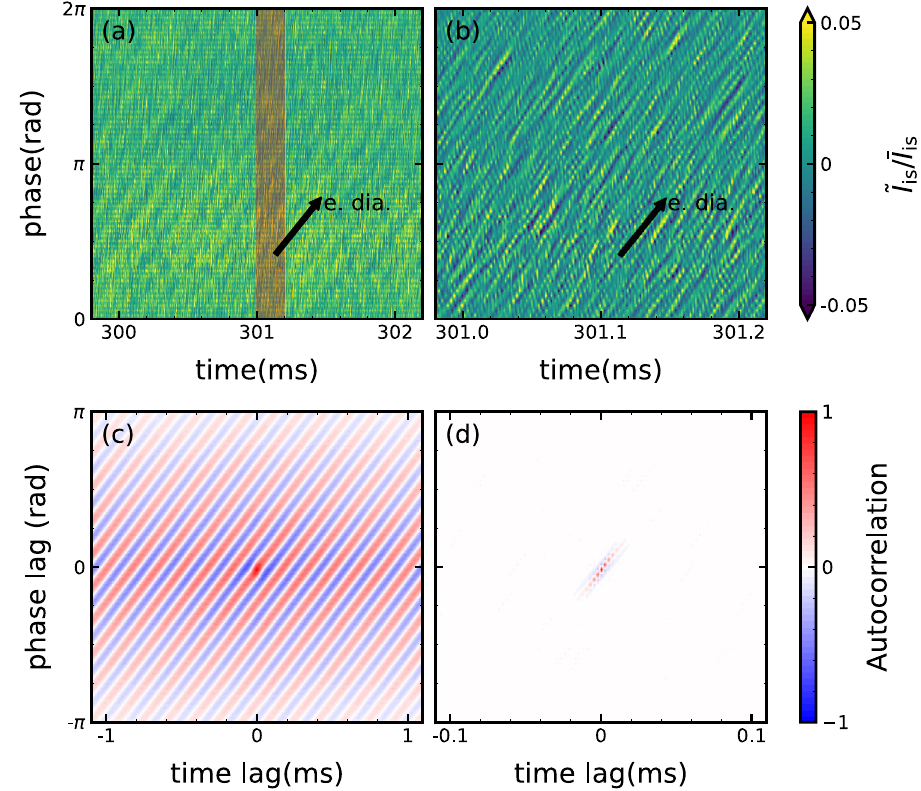
Figure 2. ( a ) Spatiotemporal evolution of normalized ion saturation current. ( b ) An enlarged view of the red shaded area in ( a ). Black arrows in ( a ) and ( b ) indicate propagation direction. Two-dimensional autocorrelation for ( c ) low-frequency component and ( d ) high-frequency component function evaluated from ( a ) and ( b